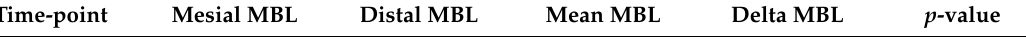
Figure 3. Radiographic appearance of the marginal bone levels at adjacent implants loaded with tapered abutment at loading (left) and one year after (right). Table 2. Mean marginal bone level (MBL) in function by year, mm (per implant analysis) and statistical significance of time-e ff ect according to the Behrens-Fisher test and the ANOVA results for implant-related